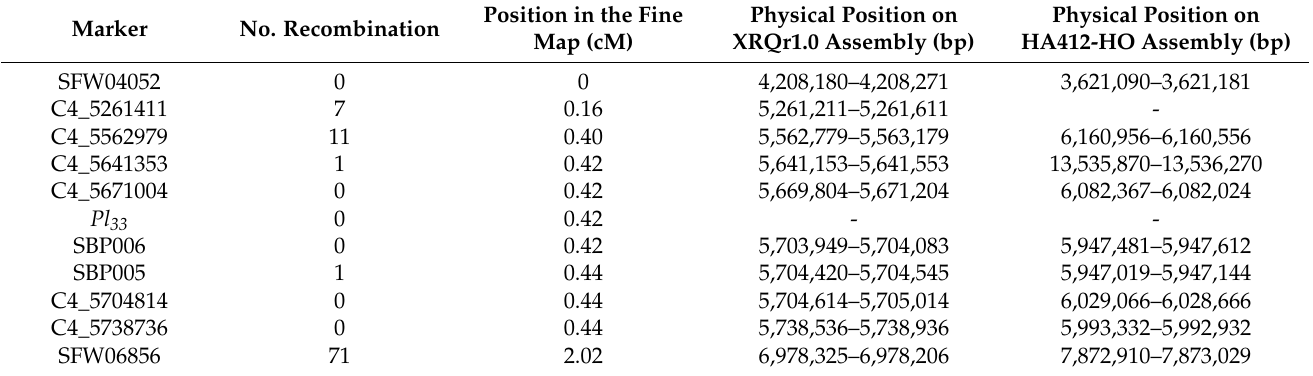
Table 3. Genetic and physical positions of the SNP markers linked to Pl 33 on a fine map of sunflower chromosome